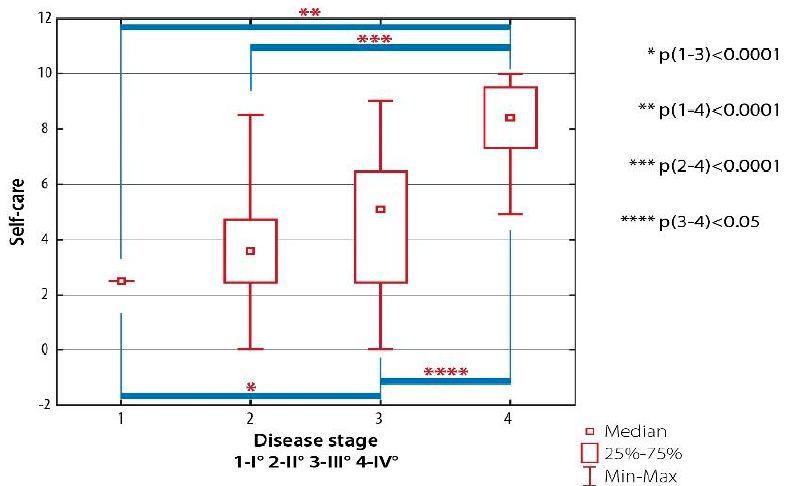
Figure 4. Inter-group differences in the quality of life evaluated with AIMS-2: self-care domain, depending on the severity of radiological changes (the Steinbrocker classification).